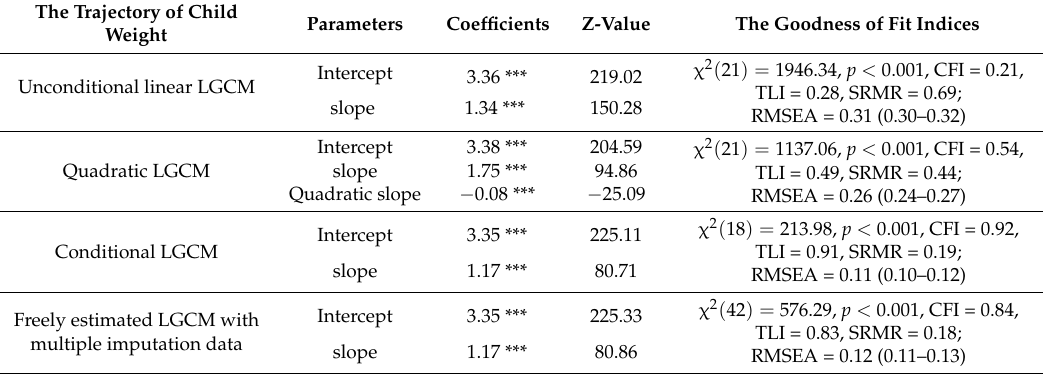
Table 3. Parameter estimates of unconditional LGCMs for the trajectories of child weight aged 0–18 months old.